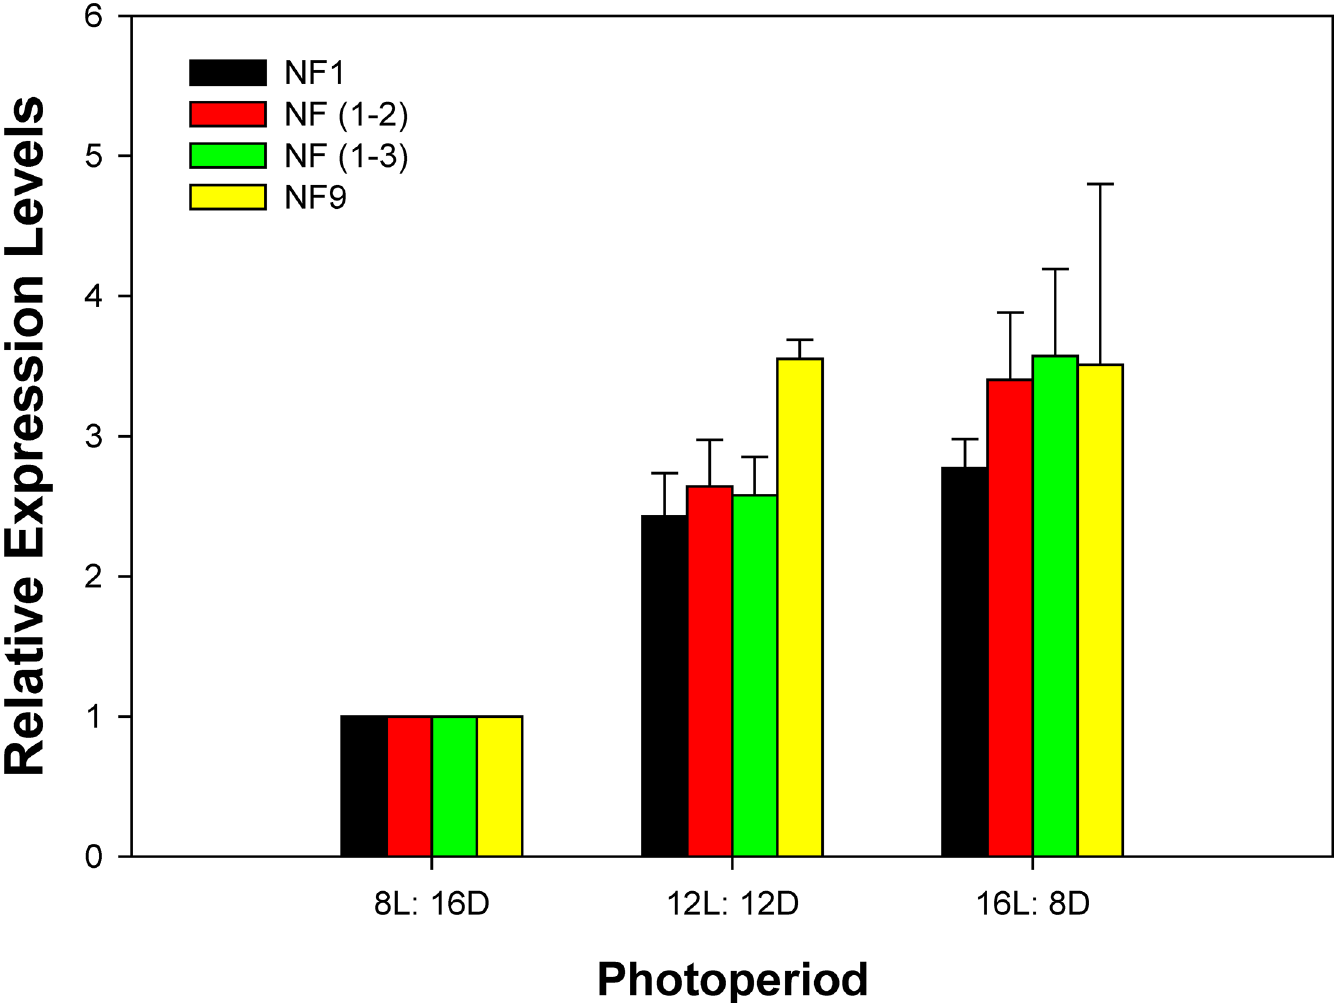
Fig 4. Validation of recommended reference genes. Expression profiles of tim gene under three photoperiod conditions were investigated using different combinations of reference genes. NF1, NF (1 – 2), NF (1 – 3), and NF9 indicate that the expression of tim was normalized using the best, the top two, the top three, or, the worst reference genes, respectively. Bar represents the mean and standard error of three biological